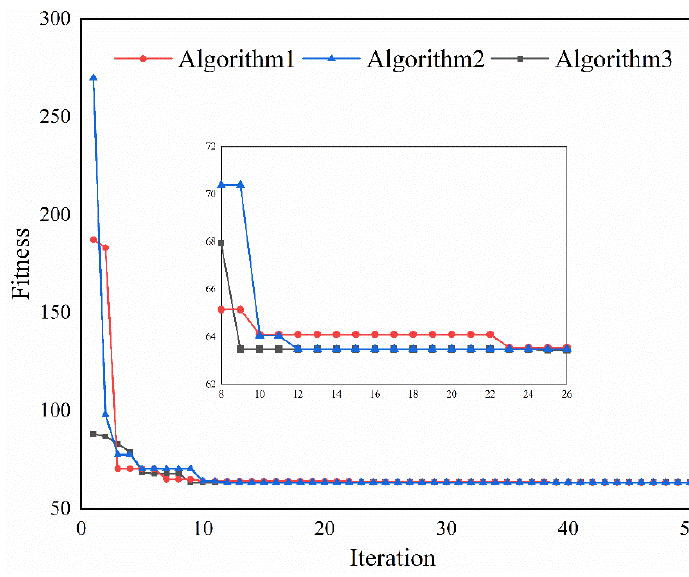
Figure 4. Comparison of evolution curves of different algorithms.